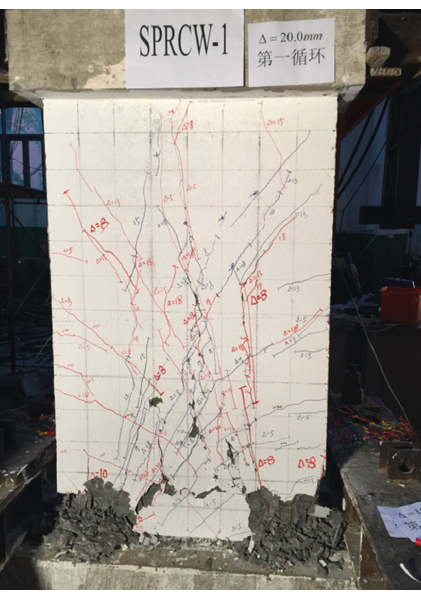
Figure 9: Diagram of cracks in the first cycle Δ � 20